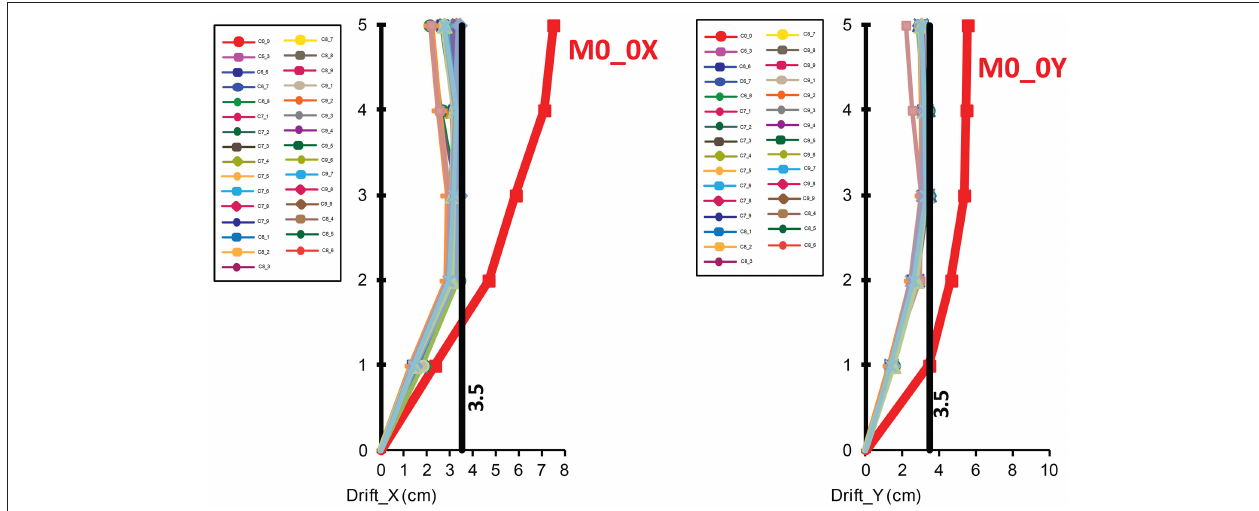
FIGURE 14 | Drift in X and Y direction for all thirty optimal solutions compared with the structure without dampers (M0_0X; M0_0Y).